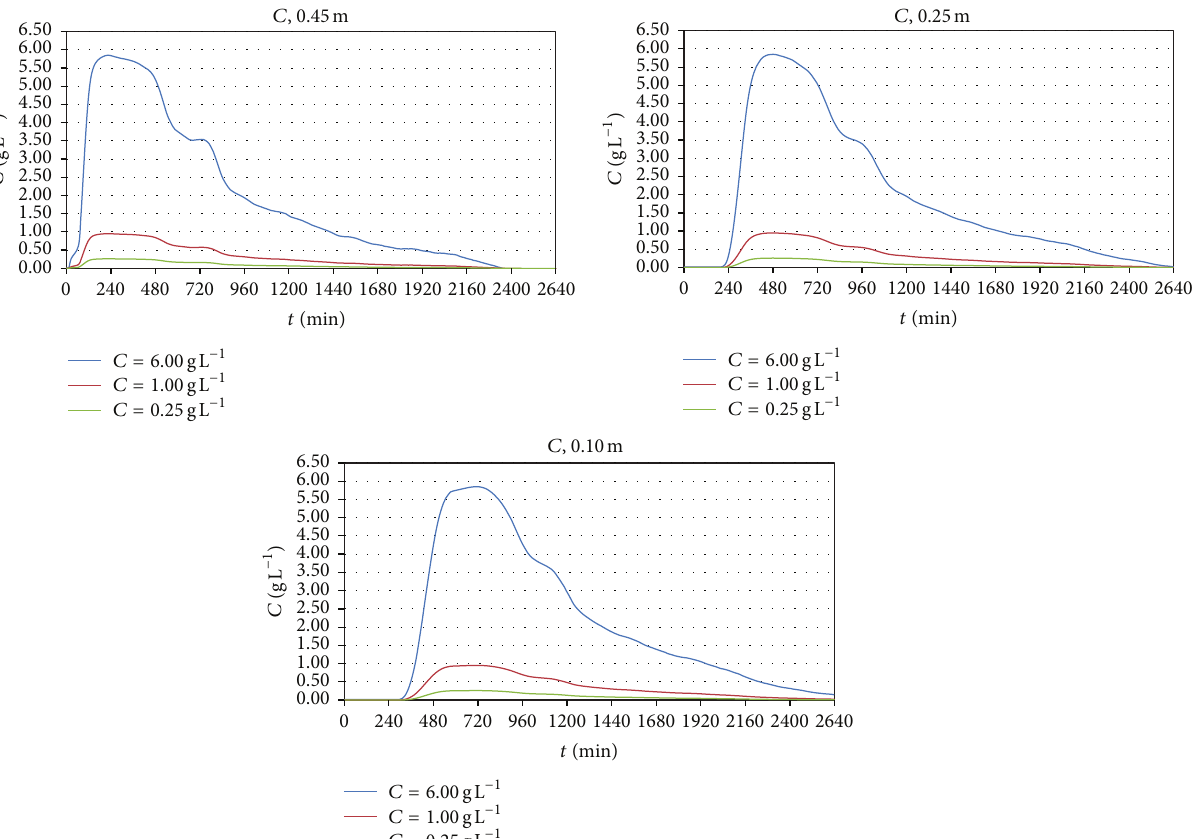
Figure 7: Salt concentration obtained by the measured SP signals at three different positions of the column.